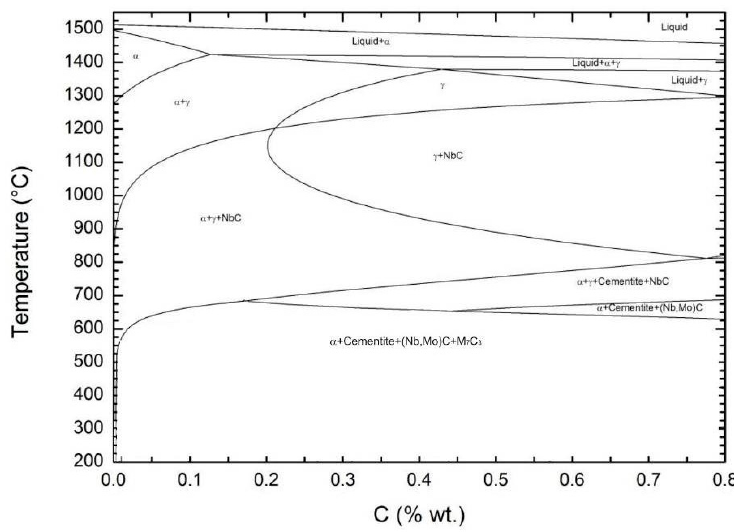
Figure 2. Pseudobinary Fe-C phase diagram of 5 Mn steel determined using Thermo-Calc.